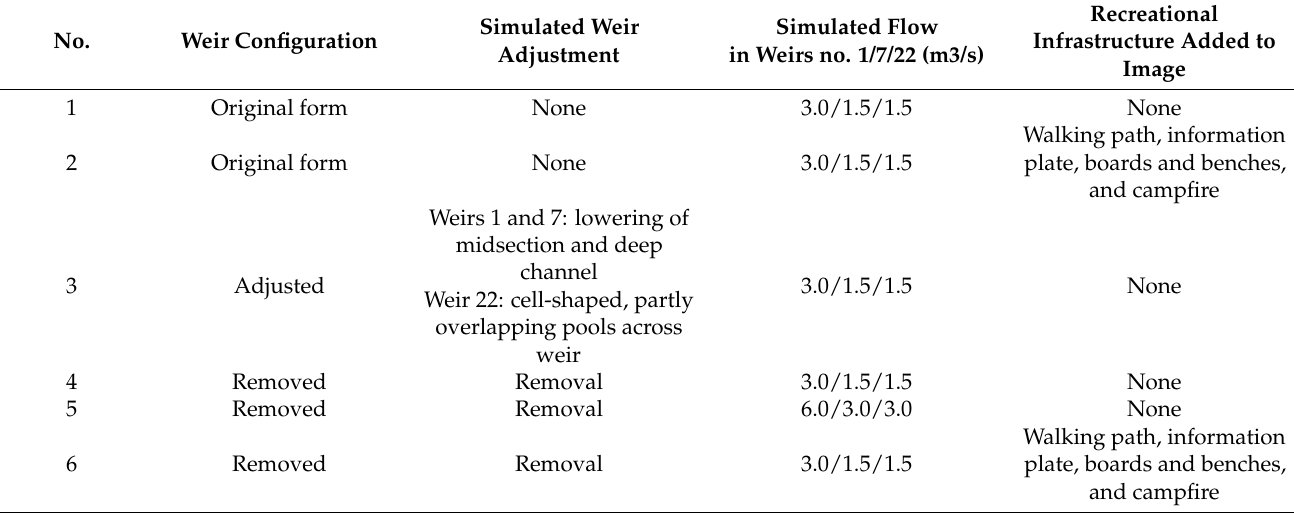
Table 1. Environmental measures visualized in the different scenarios in this